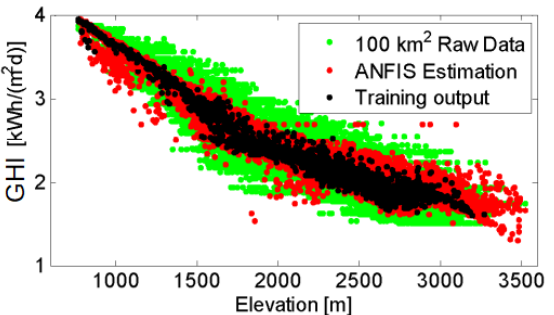
Figure 11. Comparison of raw radiation data versus ANFIS training and final ANFIS estimation as a function of terrain